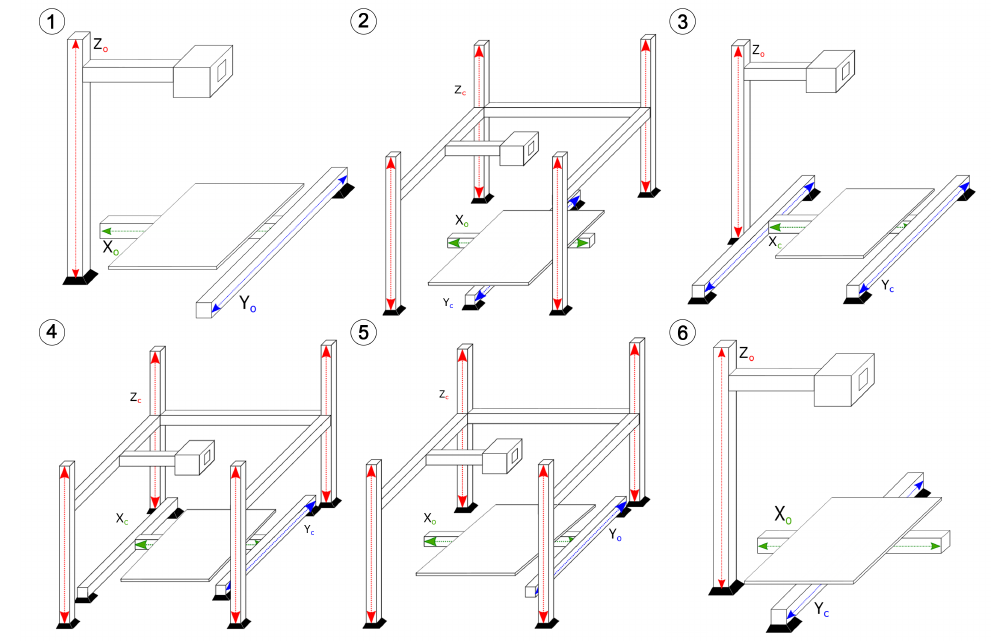
Figure A9. Fixed axes X H , Y H , Z B and actuated axes X B , Y B , Z H